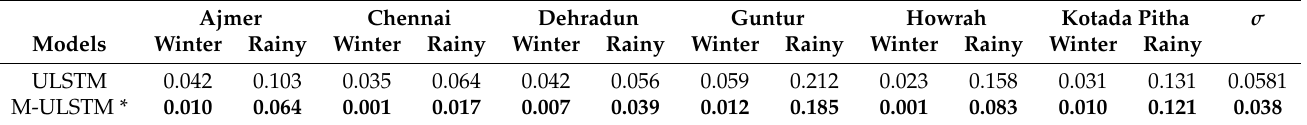
Table 6. The forecasting performance of M-ULSTM and ULSTM measured on nRMSE.